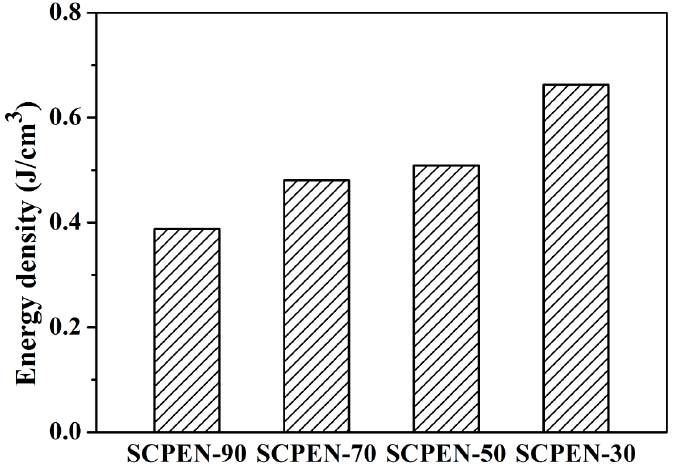
Figure 10. Energy density of SCPEN films at 1 kHz.